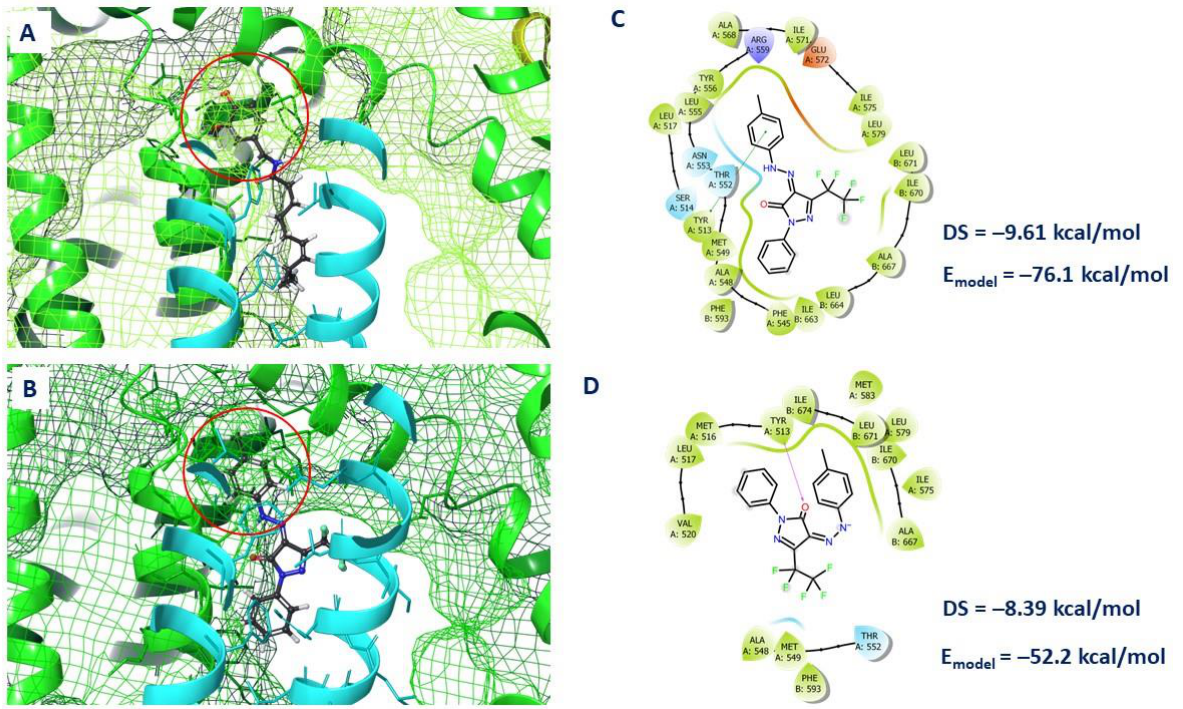
Figure 7. Location of capsaicin ( A ) and compound 6b ( B ) in the vanilloid binding site: the location of the aromatic substituent is highlighted in red. Contacts between atoms of neutral ( C ) and deprotonated ( D ) forms 6b and a.a. of binding site: π - π stacking is shown by the green line; H-bond — violet arrow; the arrow shows the direction of the hydrogen bond. The first value corresponds to the docking score (DS), the second to clustering energy (E-model).